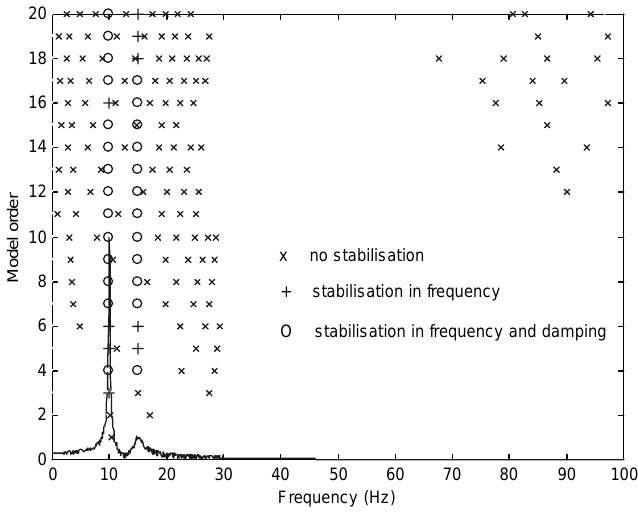
Fig. 6. Stabilisation Diagram with Exponential